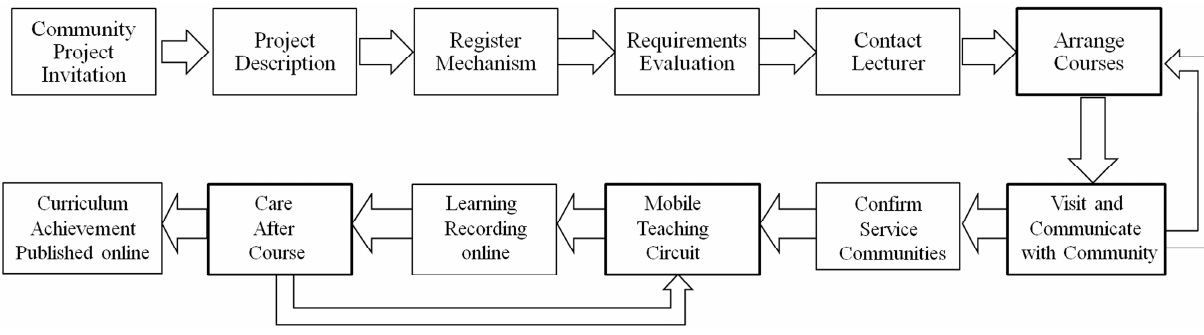
Figure 2. ICT teaching process of PunCar